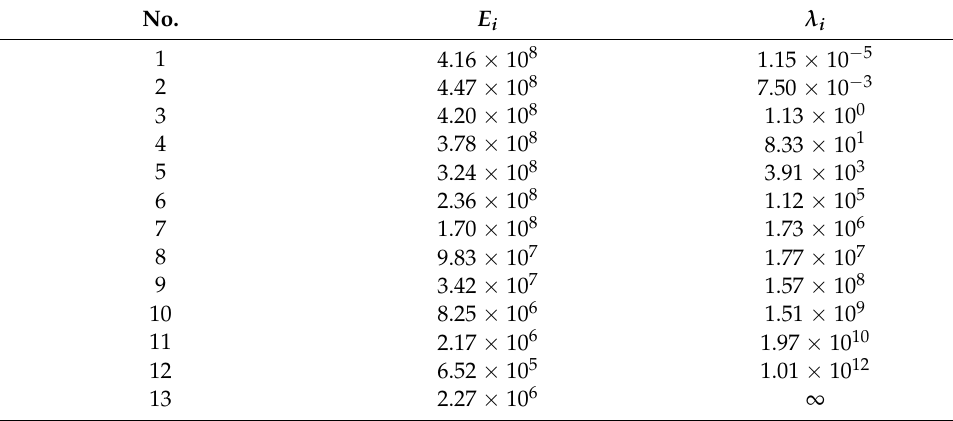
Table 7. E i and λ i for Polymer